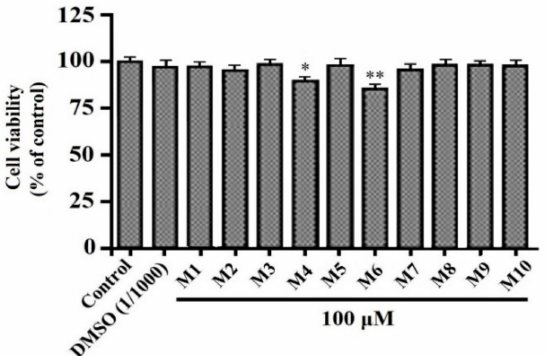
Figure 1. E ff ects of antioxidant peptides (M1-M10) from miiuy croaker ( Miichthys miiuy ) muscle on viabilities of HepG2 cells at 100 µ m. Means ± SD (n = 3) are used to express the experiment data. ** p < 0.01, * p < 0.05 versus normal control